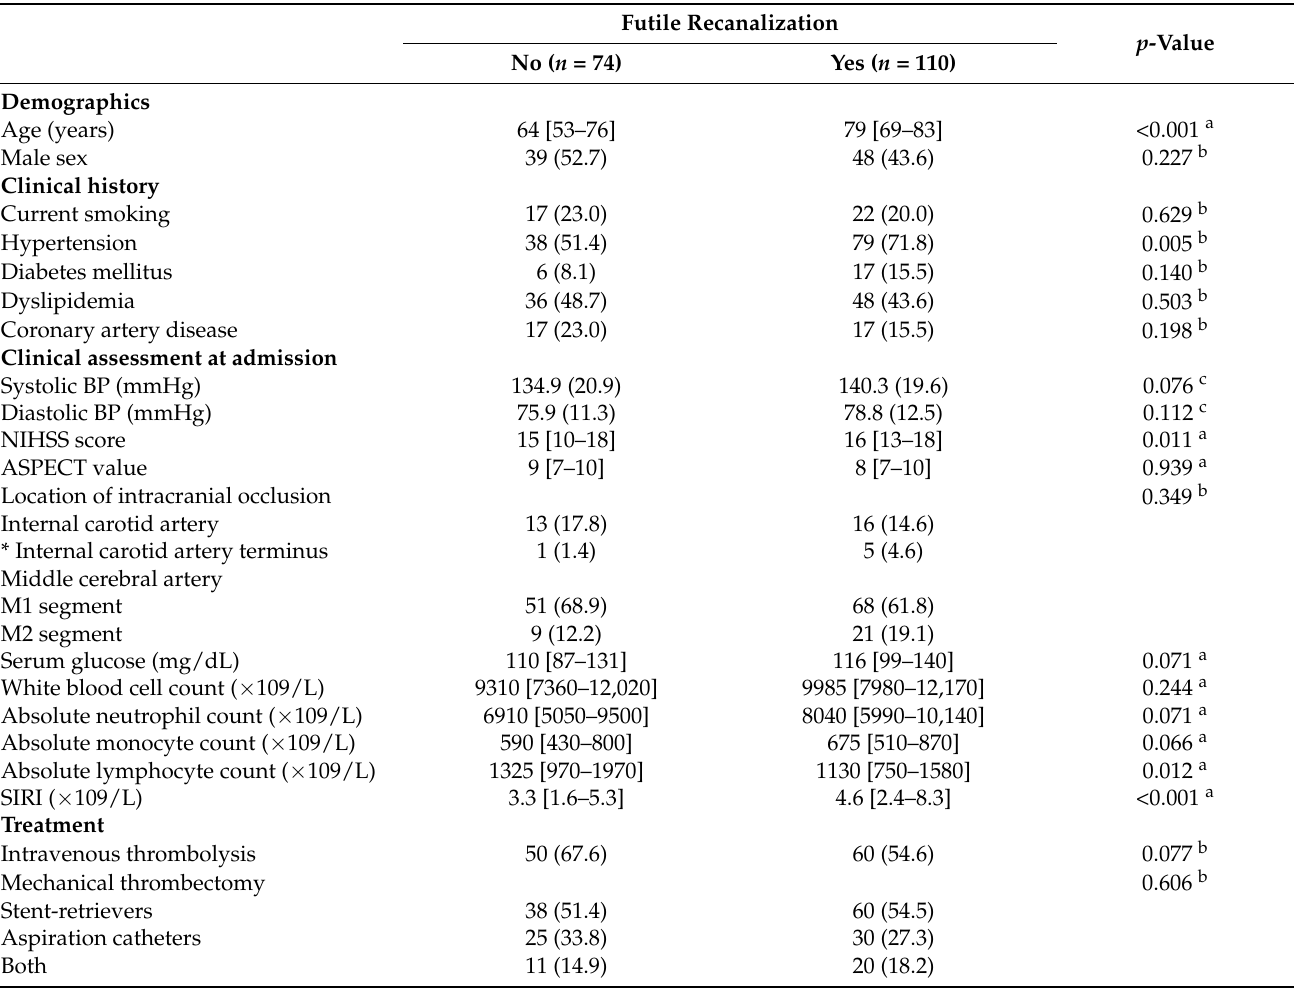
Table 1. Baseline characteristics of